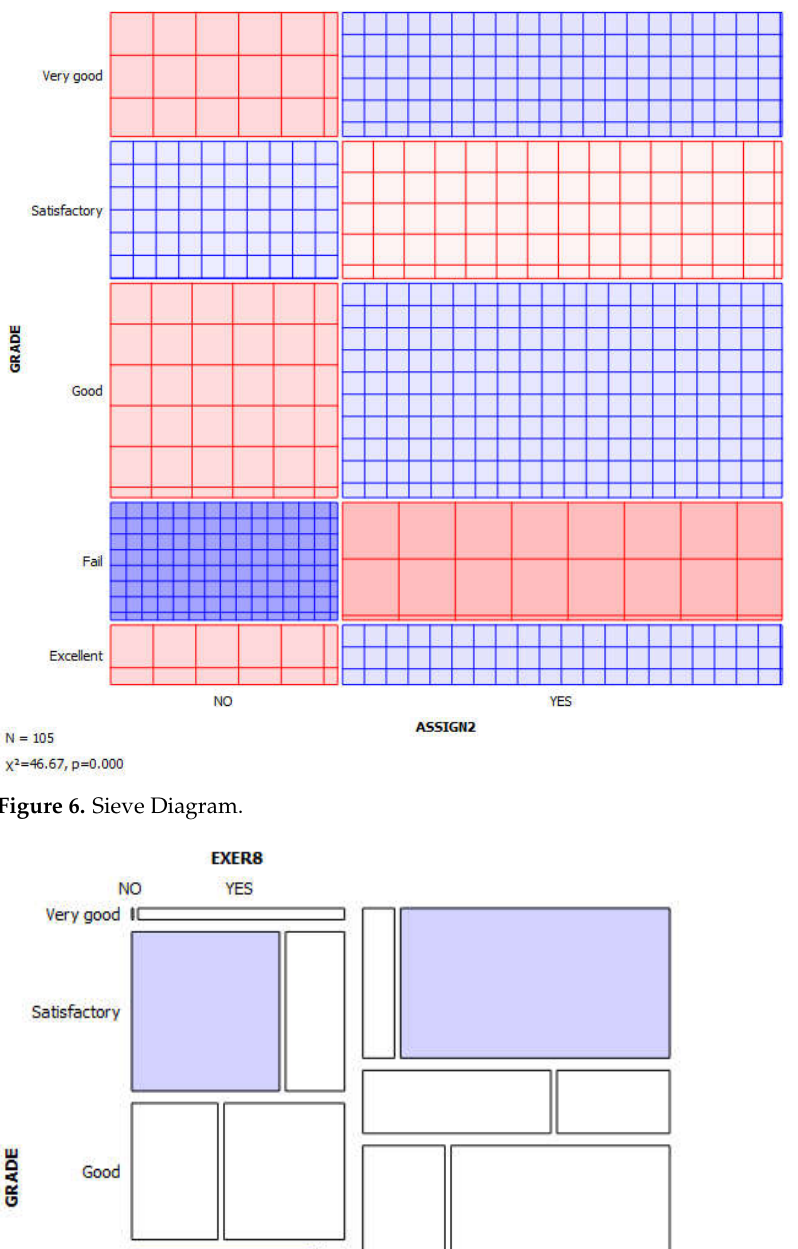
Figure 7. Mosaic display.